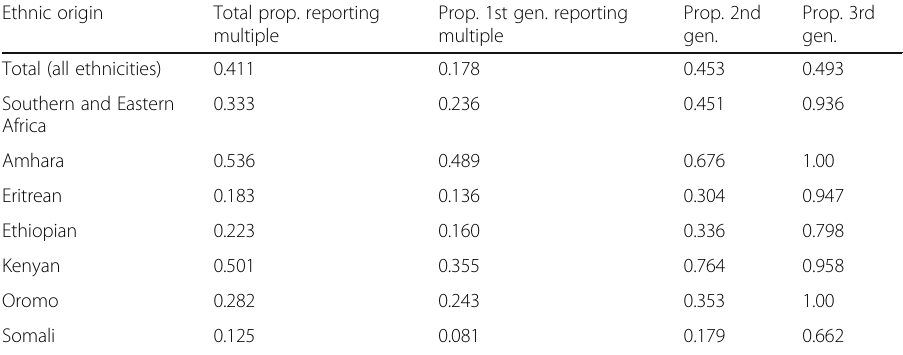
Table 5 Proportions of generational groups reporting multiple ethnic identities in 2016 census Ethnic origin Total prop. reporting